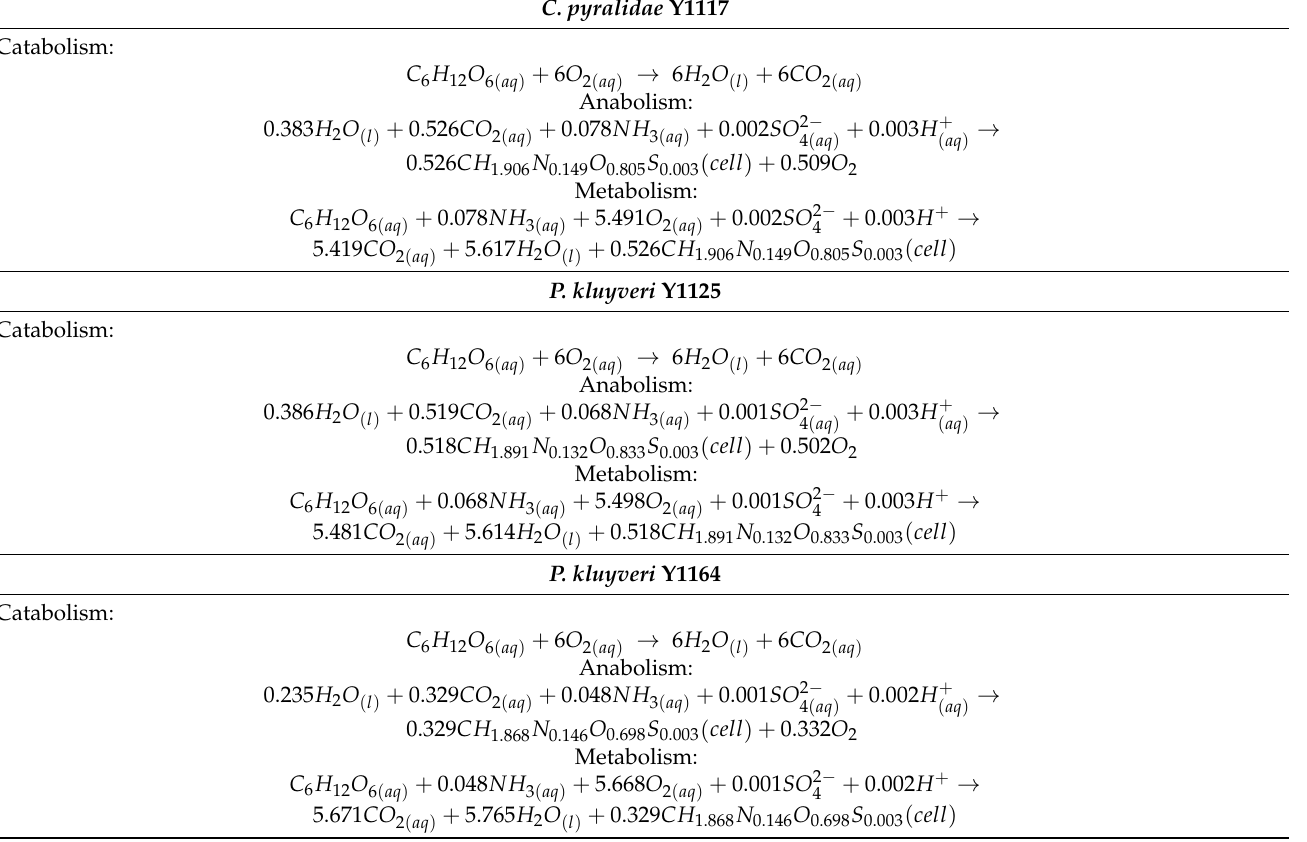
Table 6. Microbial growth equations of C. pyralidae Y1117, P. kluyveri Y1125, and P. kluyveri Y1164 dur- derived and balanced by determining the stoichiometric coefficients using the conservation